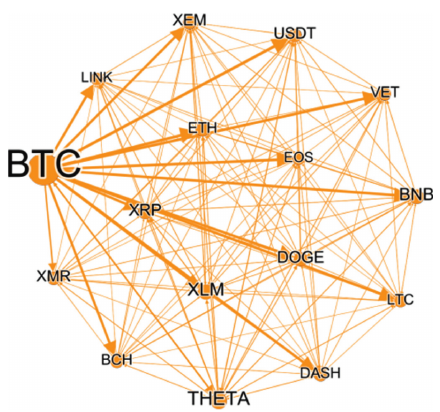
Figure 48: Risk spillover under E8.